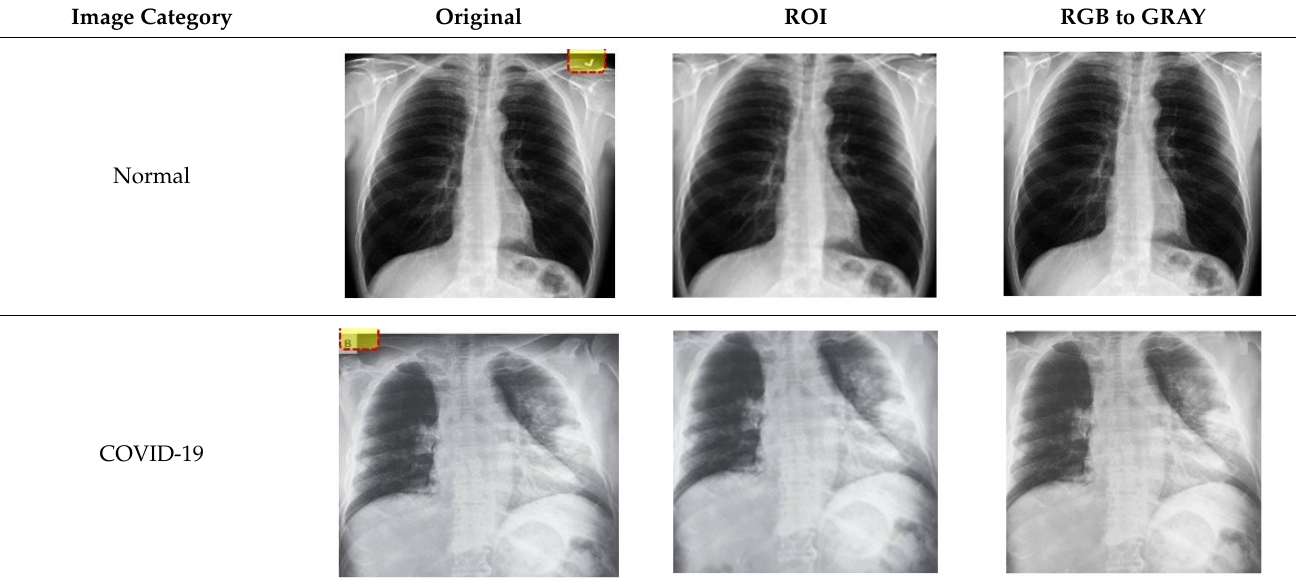
Table 2. Proposed image processing: original, ROI, and RGB to